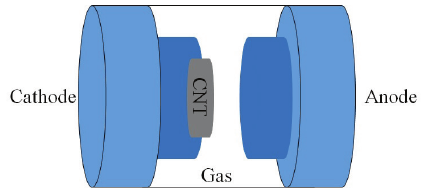
Figure 4. Fabricated CNT using an arc discharge method. The chamber with graphite electrodes is filled with helium, hydrogen, or methane. The high temperature causes the graphite to sublimate and move towards the cathode and create a CNT layer on it.